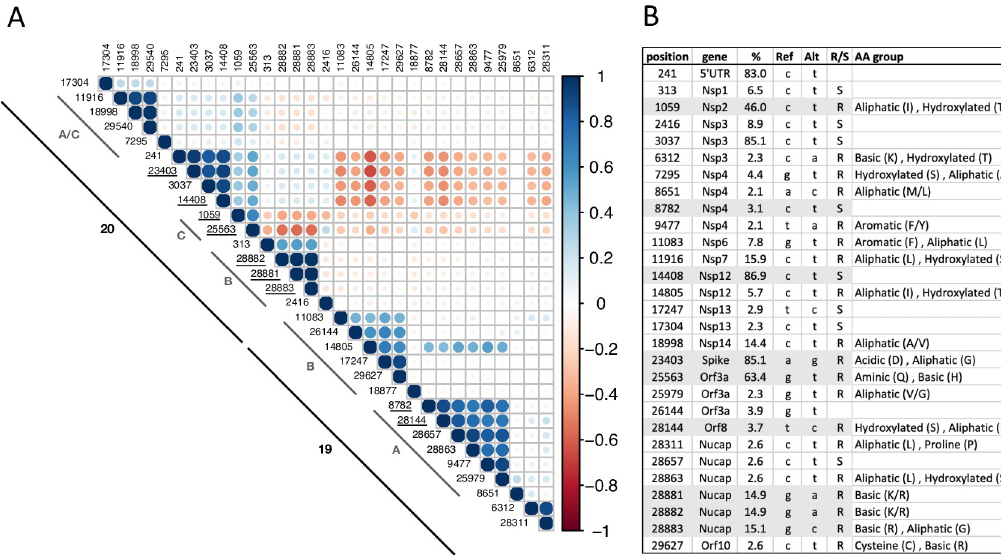
Fig 3. SARS-CoV-2 frequently observed mutations. 29 mutations along the SARS-CoV-2 genome occurred in > 2% of the 372 Israeli sequences. (A) Correlation table of the frequently observed mutations. Positive/negative correlations are denoted in blue/ red respectively. Known clade-defining mutations are underlined and clade association is noted. (B) Listed for each frequently observed mutation its position, gene, % frequency in Israeli sequences, nucleotide substitution, whether it’s an R or S mutation, and in case of an R mutation, the originating and altered AA group. Known clade-defining mutations are highlighted in